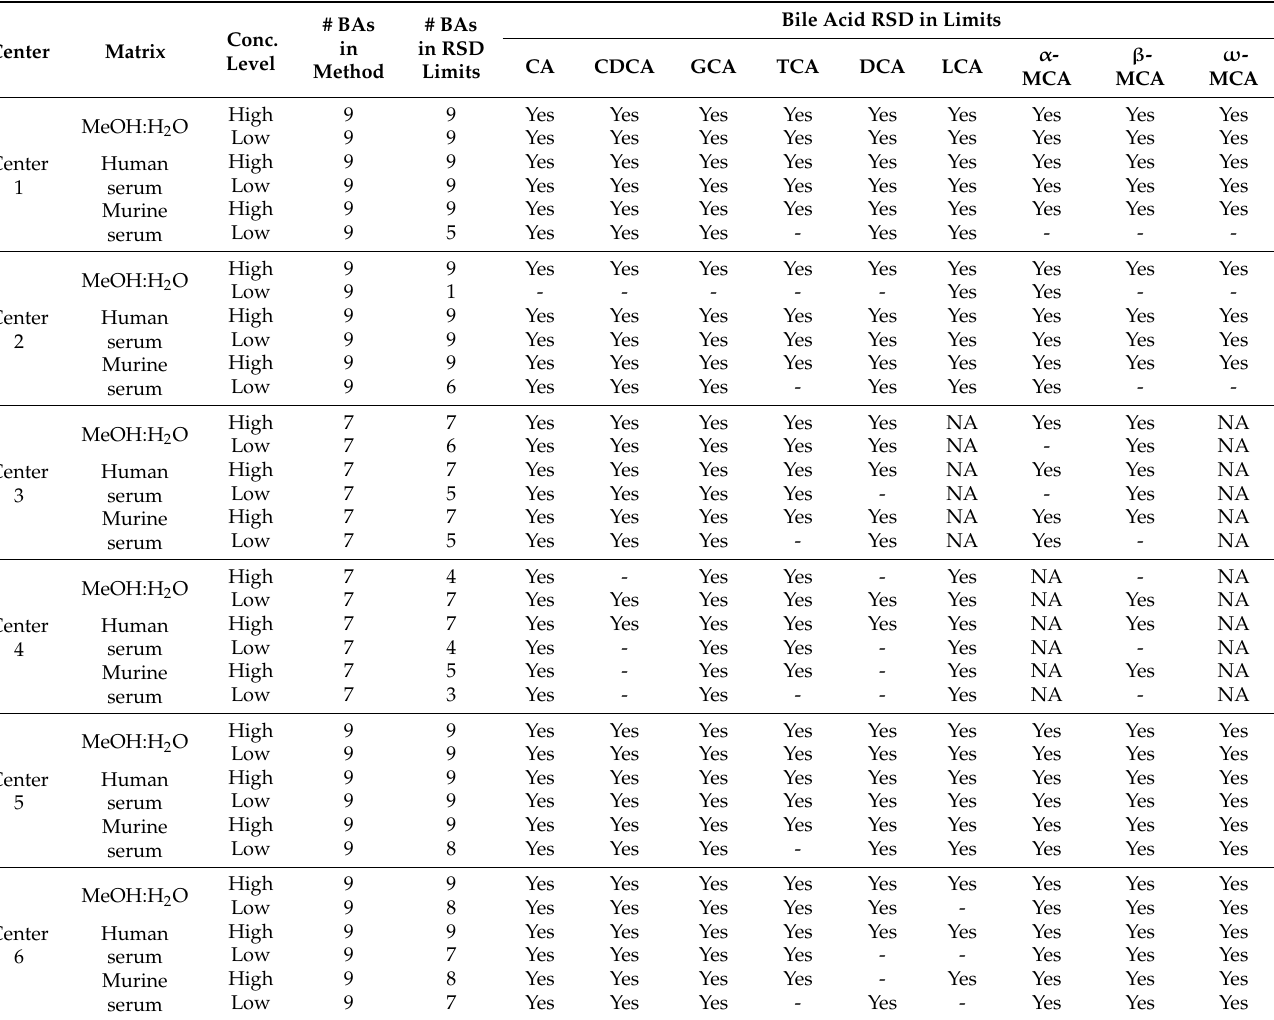
Table 2. Bile acid analyses within precision limits based on relative standard deviation (RSD). NA = not applicable, those BAs are not covered by the specific